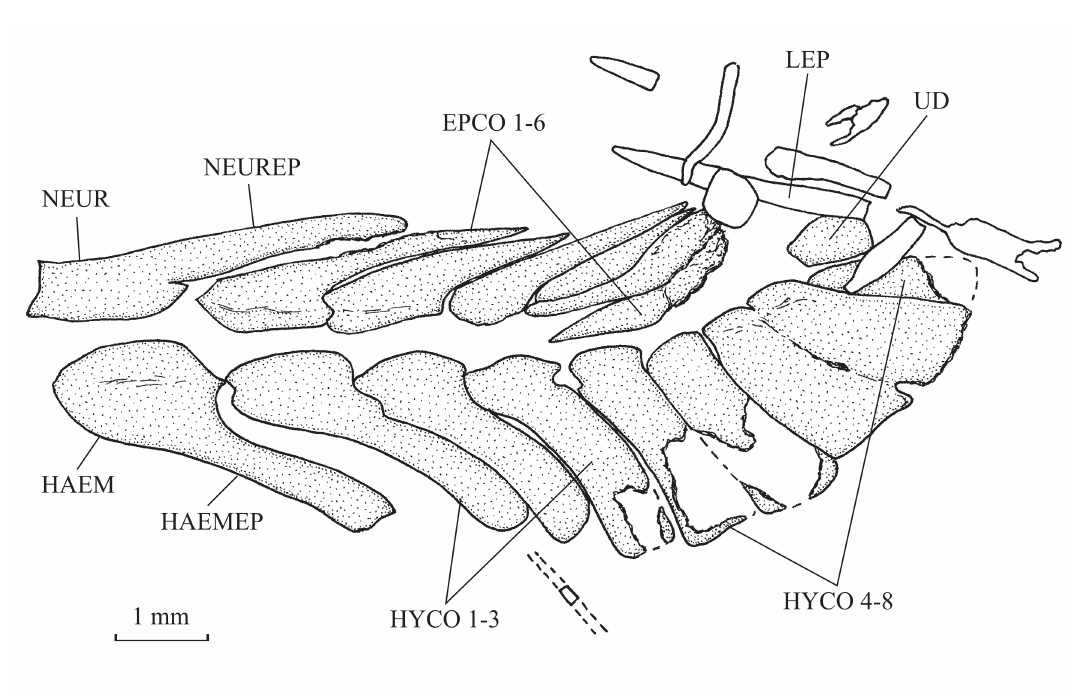
Fig. 9. Joinvillichthys lindstroemi (Davis, 1890). Caudal skeleton of sample IRSNB N° P 9276.